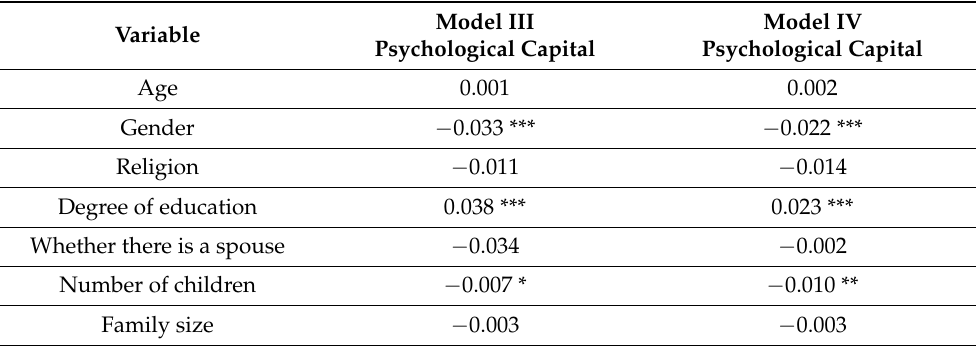
Table 6. Regression estimation results of bonding social capital, bridging social capital, and linking social capital and their effects on psychological